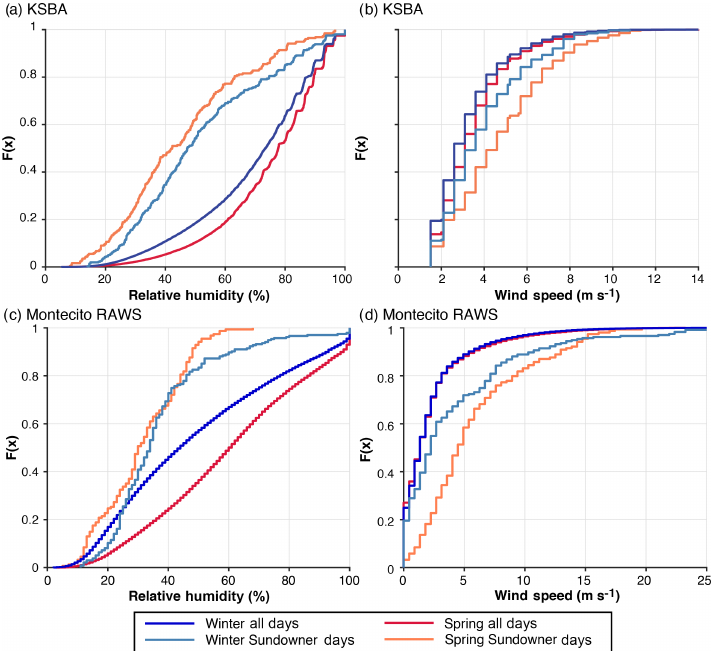
Figure 2. (a) Cumulative distributions of relative humidity at KSBA during the extended spring (March–June) Sundowner maxima and extended winter (November–February) Santa Ana maxima. (b) As in (a) except for wind speed at KSBA. (c, d) As in (a, b) but for the Montecito RAWS. Distributions are created from either all hours (all days) or for the 5h following each identified possible top 0.5% of Sundowner events (Sundowner days) during the respective peak seasons (see Fig. 1d–f).